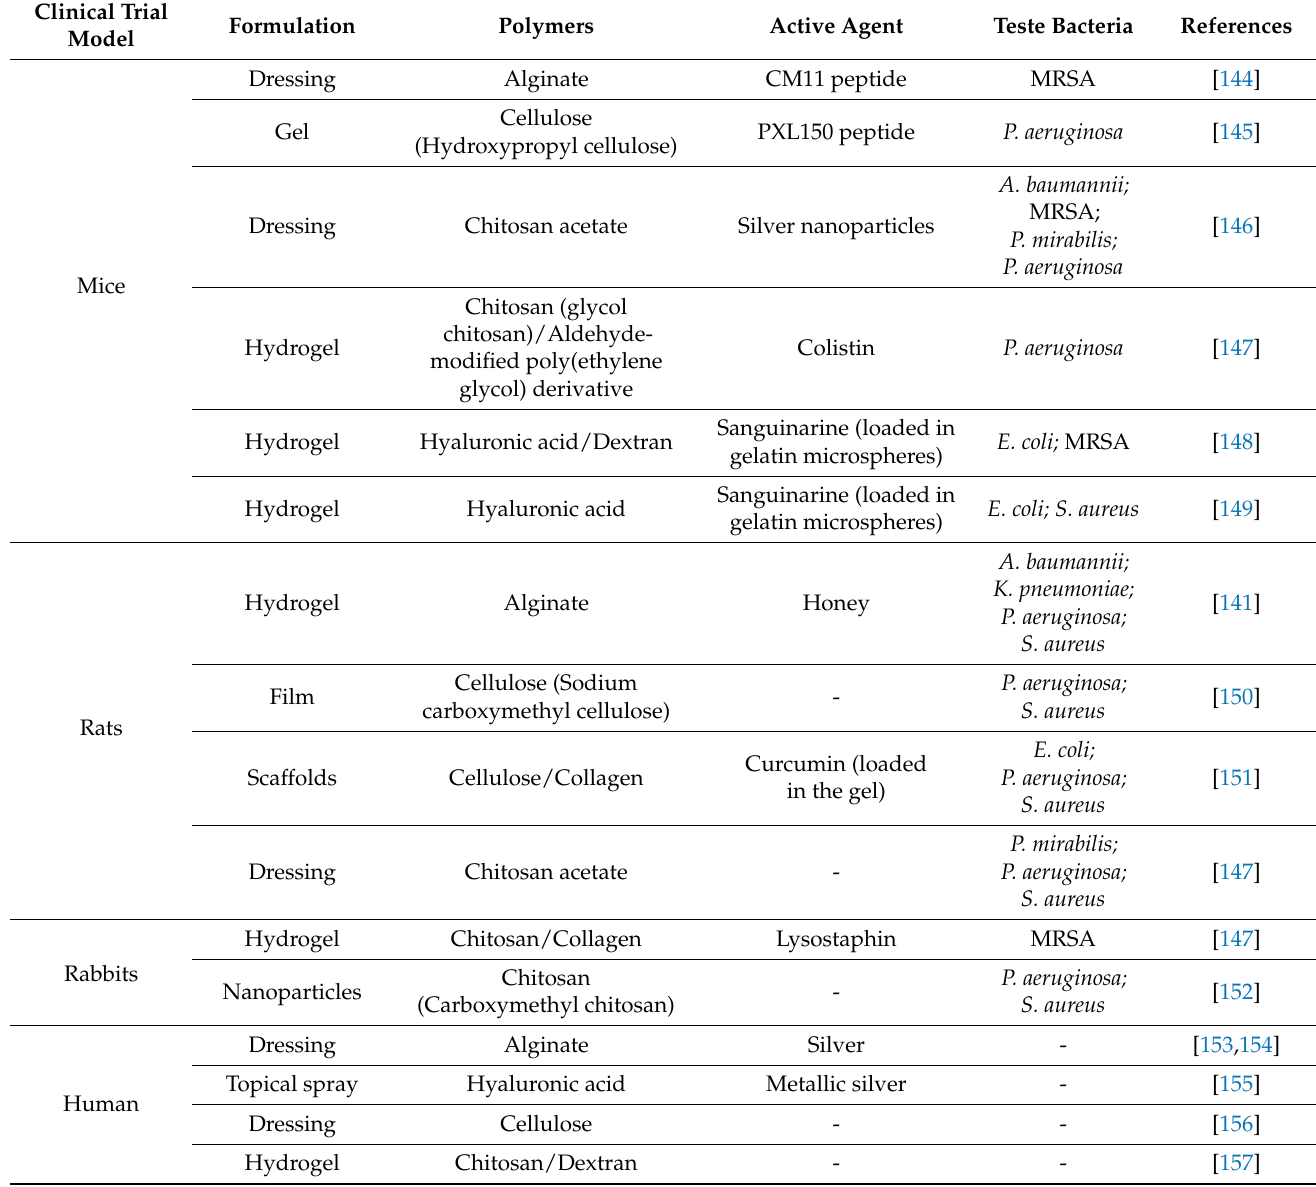
Table 3. Hydrogel based formulations used for skin tissue engineering as clinical